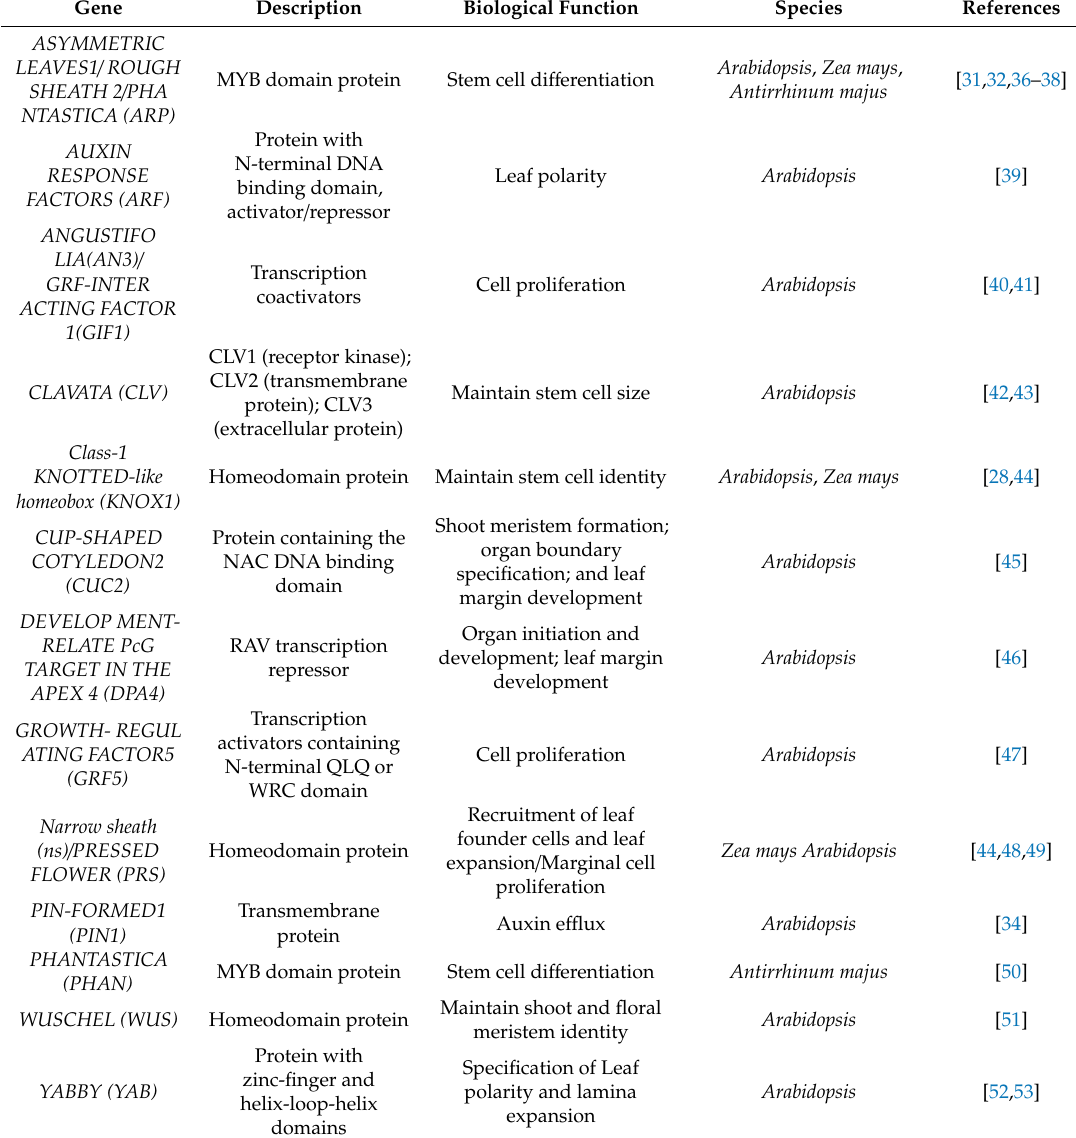
Table 1. A list of the key genes involved in leaf growth and di ff